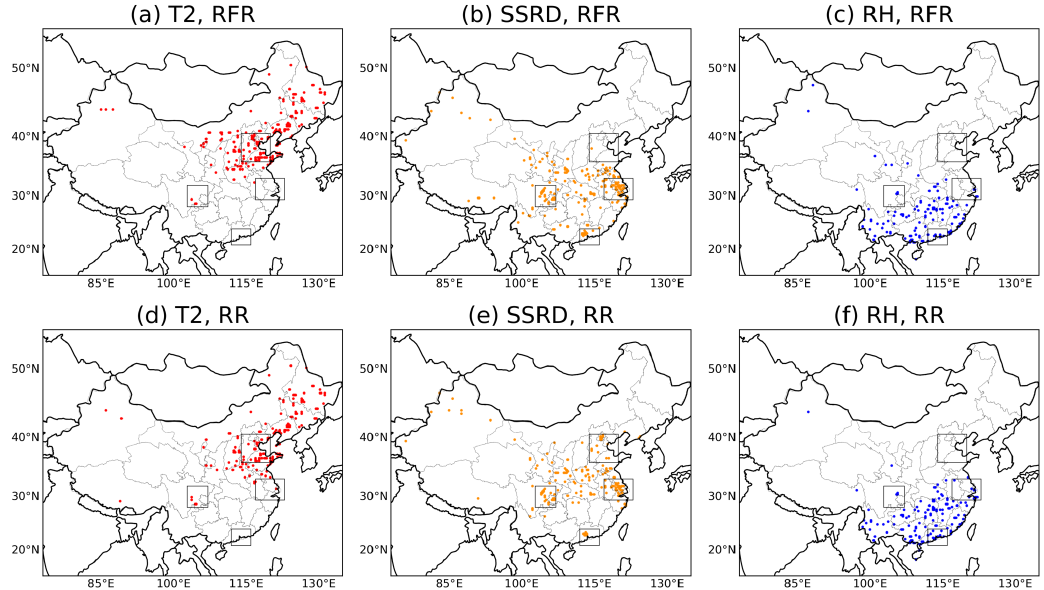
Figure 8. (a–c) Most important meteorological driver at each grid location from April–October of 2015–2019 as identified by Gini im- portance using RFR. (d–f) The same, but using absolute magnitudes for the slopes of RR. Variables as labelled. Relative humidity (RH) dominates in the south and southeast, surface solar radiation downward (SSRD) primarily in central China and eastern China, and tempera- ture at 2m (T2) in north and northeast